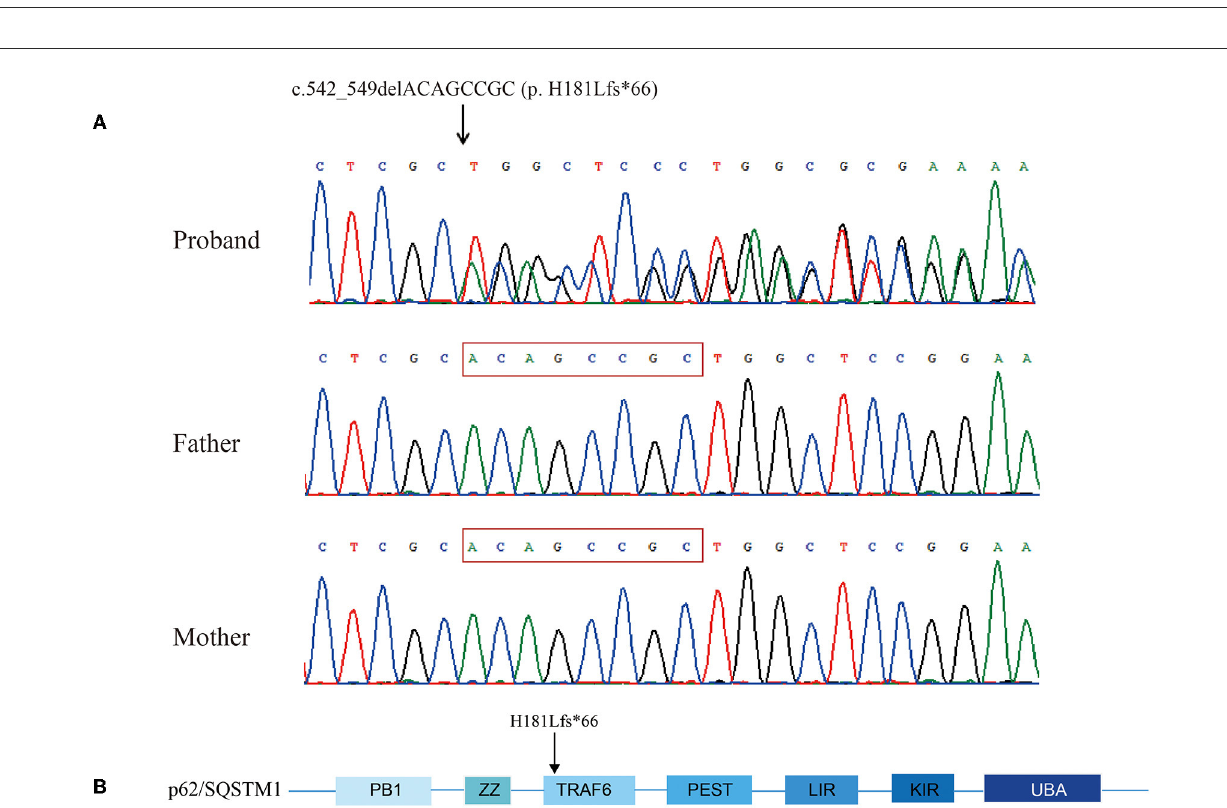
FIGURE4 Chromatograms showing sequencing analysis of heterozygous frameshift mutation c.542_549delACAGCCGC (p. H181Lfs*66) in SQSTM1 in the proband and her parents’ sequences. The red frame was the deletion part of the proband (A) . Schematic view of p62/SQSTM1 functional domains. PB1, Phox and Bem1; ZZ, zinc finger motif; TRAF6, TNF receptor-associated factor 6; PEST, proline, glutamic acid, serine, and threonine domain; LIR, LC3 interaction region; KIR, KEAP1 interaction region; UBA, ubiquitin association domain. The amino acid number indicates the proband’s mutation (B)